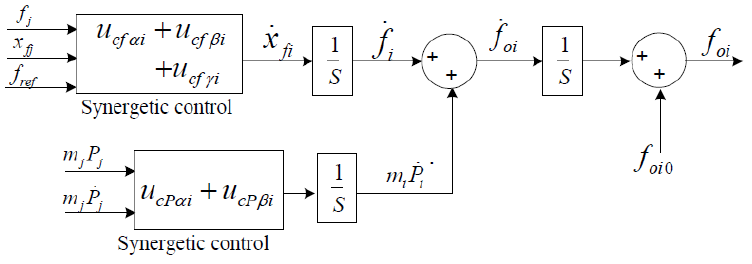
Figure 5. Diagram of synergetic secondary frequency control.